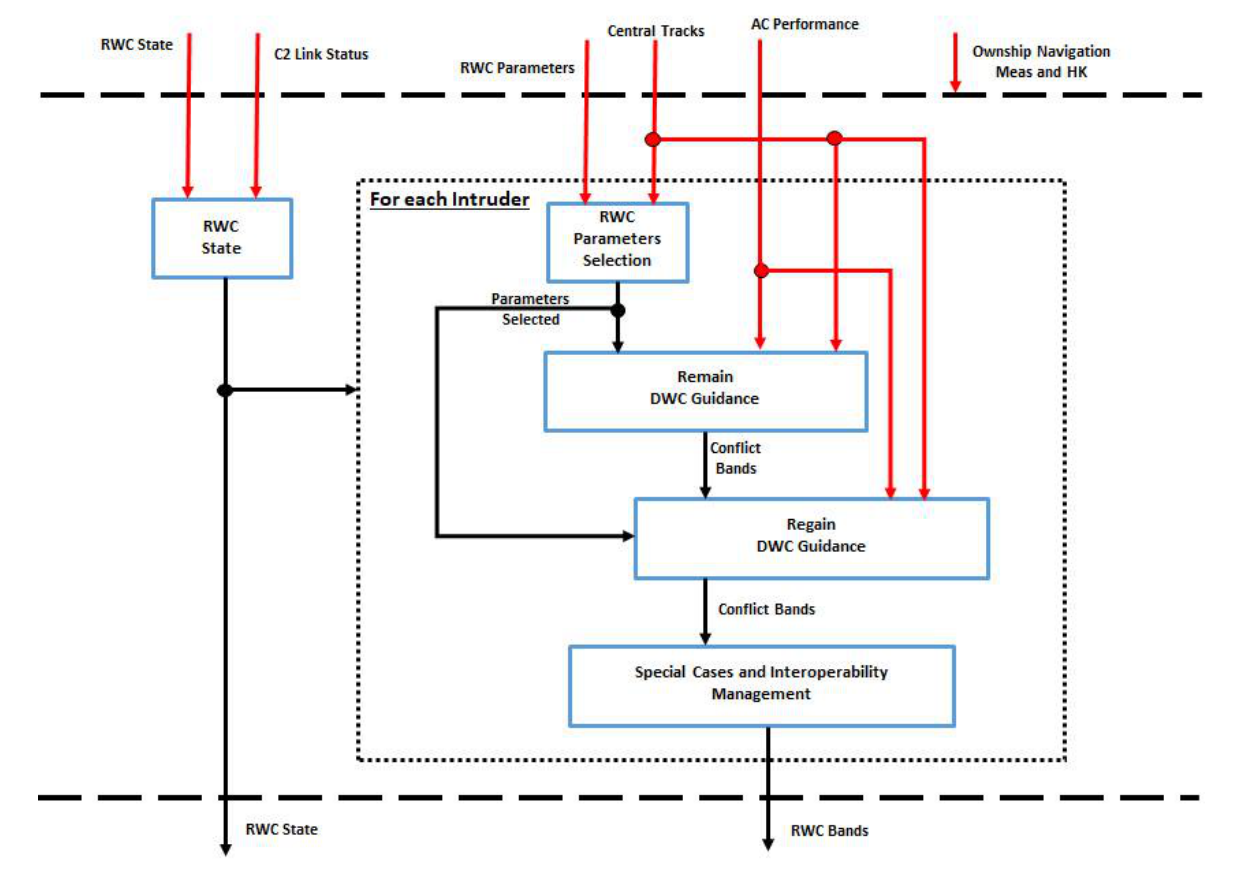
Figure 8. RWC guidance module detailed architecture.